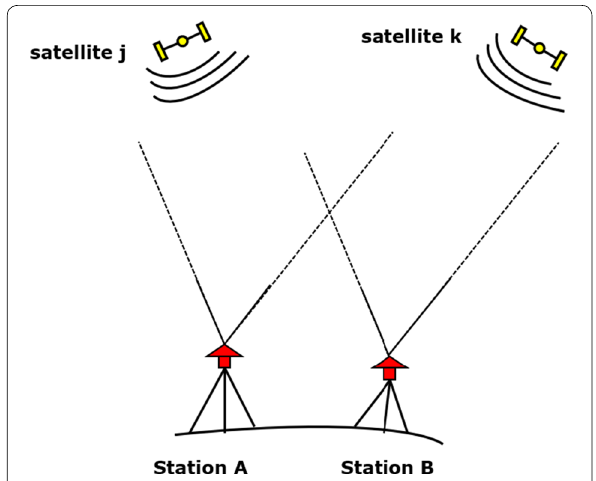
Fig. 1 Geometry of the relative positioning and DD; the rays are almost parallel at the stations A and B due to the great distance to the satellites of 20,000 km (~ 0.01° difference for a 1 km station